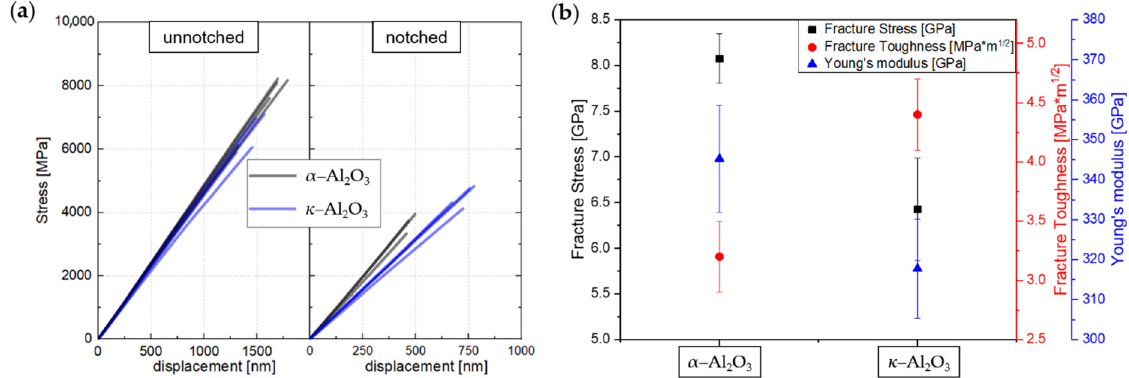
Figure 5. ( a ) Stress–displacement curves of the unnotched and notched micro-cantilevers. ( b ) Fracture stress, fracture toughness and Young’s modulus determined from the micro-cantilever bending tests.